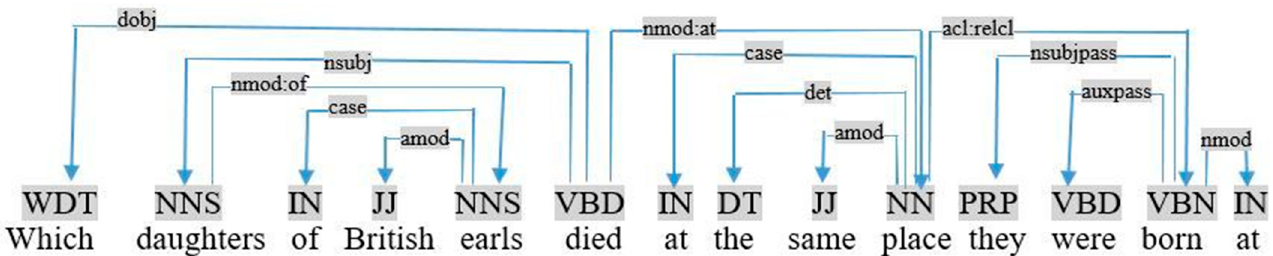
Figure 12. Graph dependency of the query «which artists were born on the same date as Rachel Stevens».